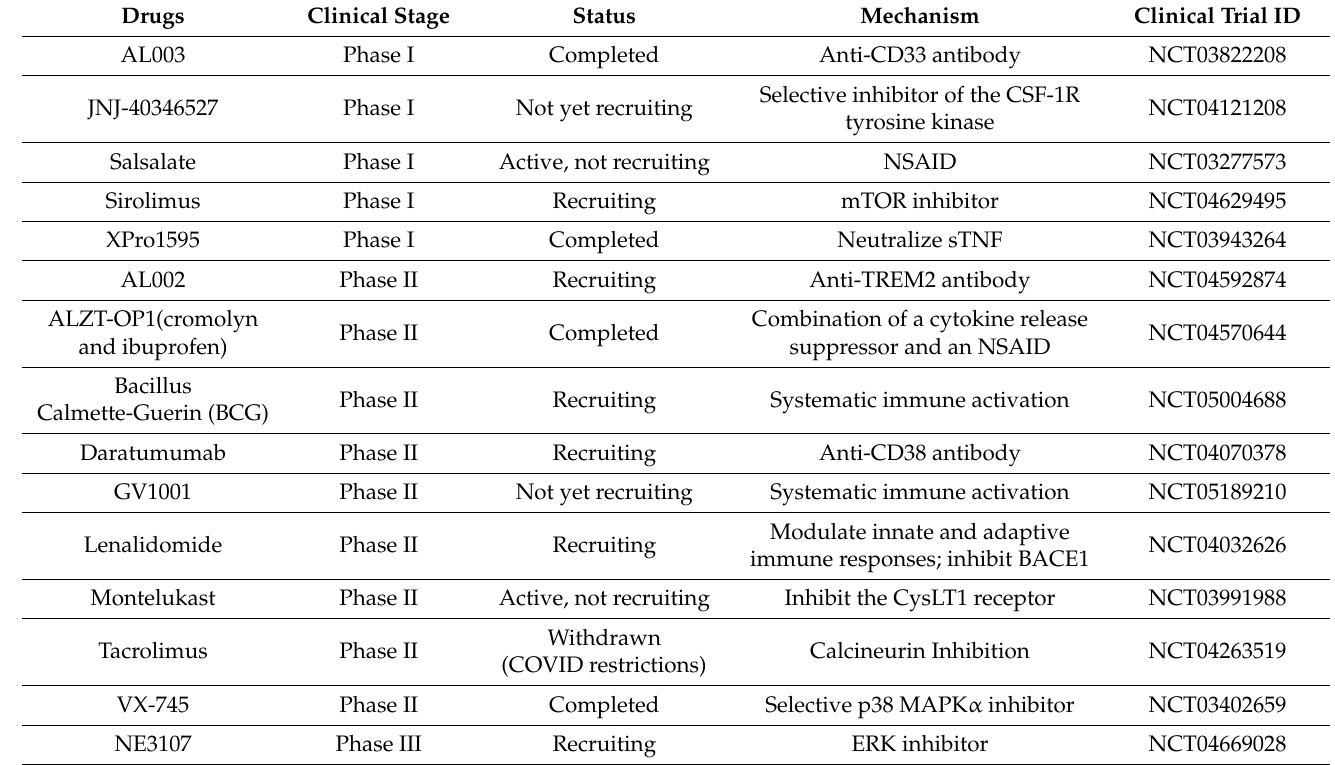
Table 2. 2021 Clinical Trials of anti-inflammatory drugs in AD and MCI